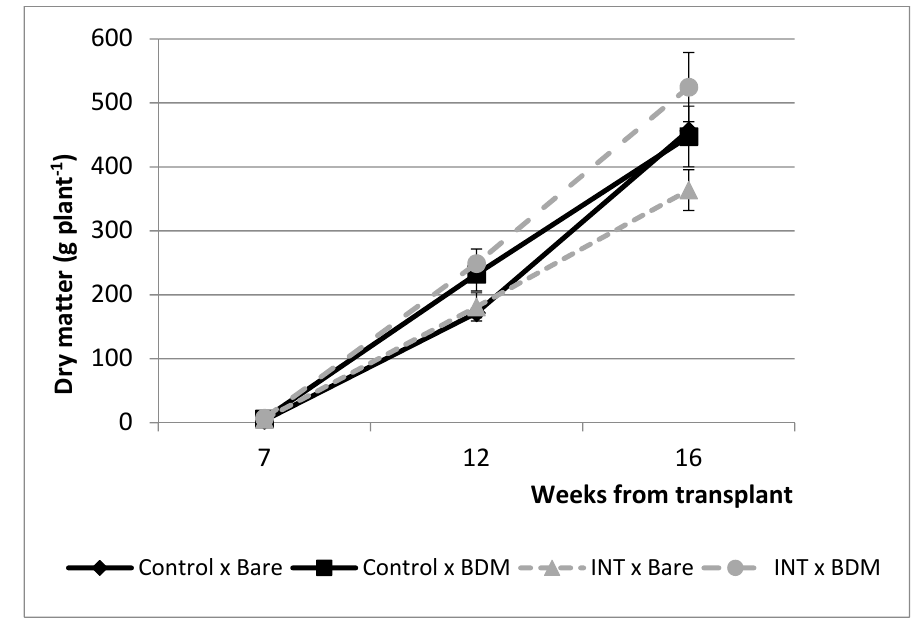
Figure 2. Dry matter accumulation in fruits of tomato cv Heinz 5508 during the 2017 crop cycle. Legend: vertical bars represent error standard of mean (N = 10) per each combination treatments in different sampling times. Control × Bare: standard farm fertilization × Bare soil; Control × BDM: standard farm fertilization × Biodegradable mulch; INT × Bare: solid digestate integrated with mineral fertilizers × Bare soil; INT × BDM: solid digestate integrated with mineral fertilizers × Biodegradable mulch.